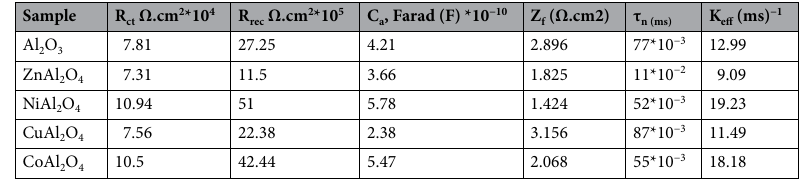
Table 1. Electrochemical Impedance of Al 2 O 3 NP s and MAl 2 O 4 with 6 cycles CdS QD s as a photosensitizer.